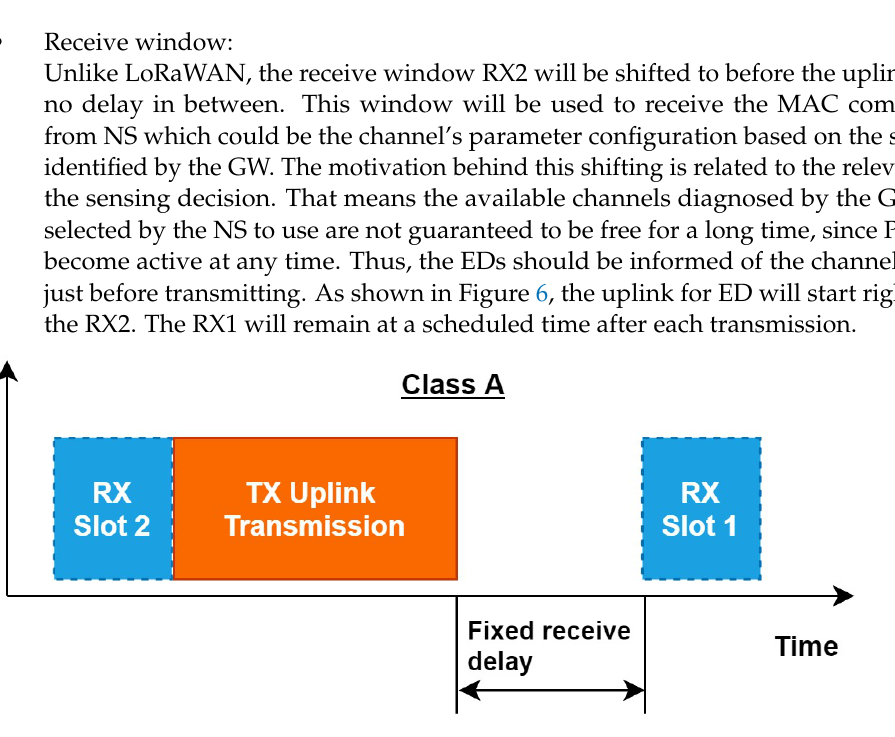
Figure 6. LoRaCog Class A